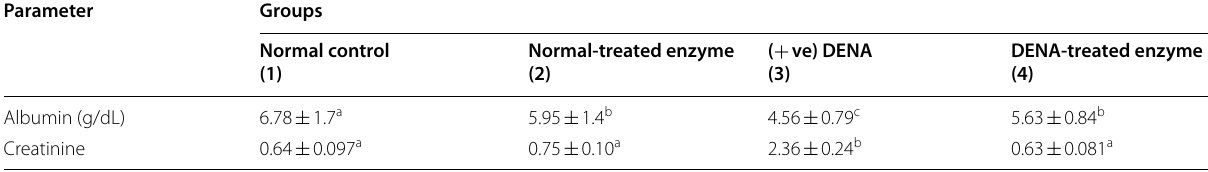
Table 3 Effect of T. viride l ‑asparaginase on albumin and creatinine levels in serum of control and DENA‑intoxicated